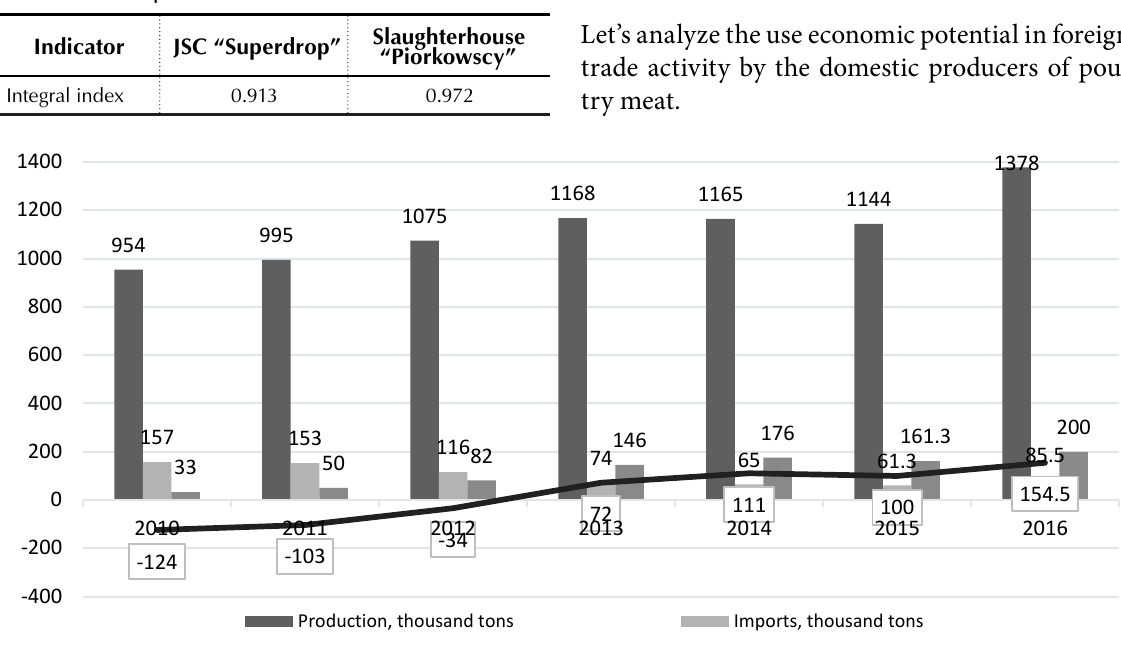
Figure 4. Analysis of the meat poultry production in Ukraine in 2010‒2016 and volume of imports and